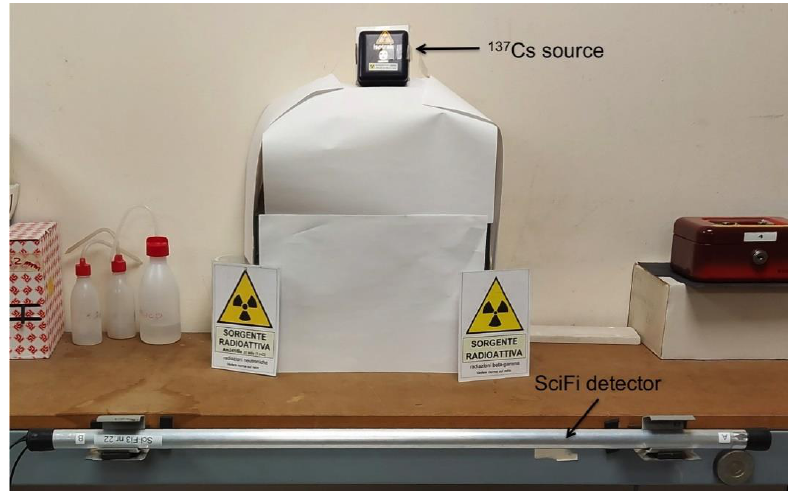
Figure 12. Measurement setup with a point-like 1.49 Mbq 137 Cs gamma source and a detector holder. The distance between the source and the mid-point of the fiber was d = 52 cm.